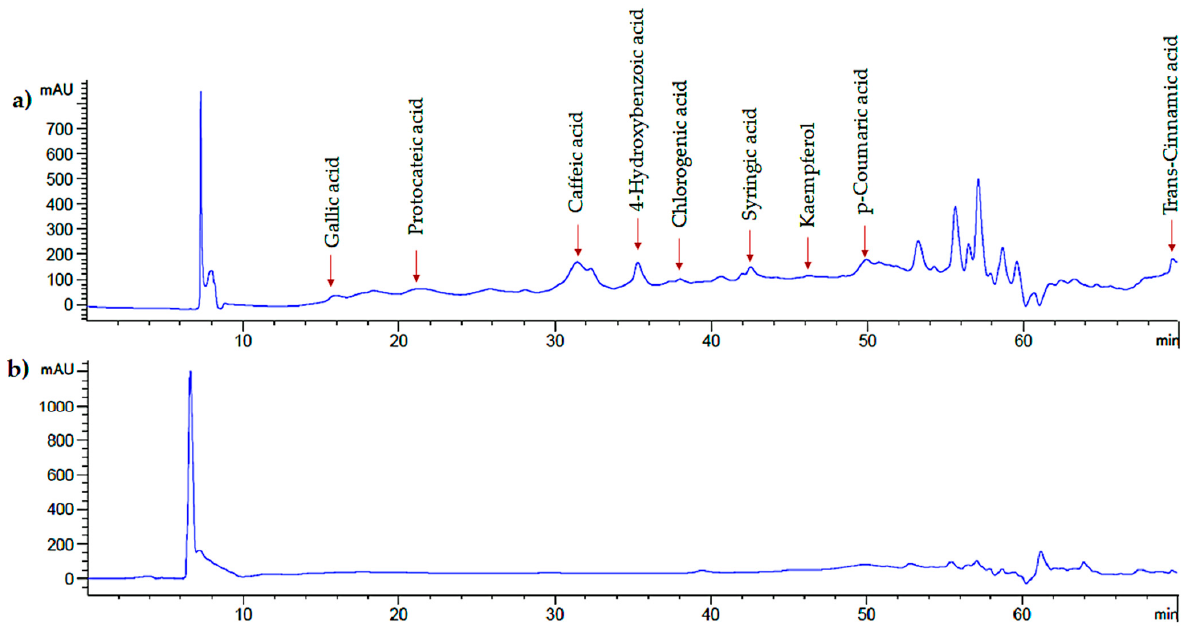
Figure 3. Soluble polyphenols chromatographic profile of Psidium cattleianum leaf extract by ultrasound-assisted extraction ( a ) and aqueous–organic extraction ( b ).